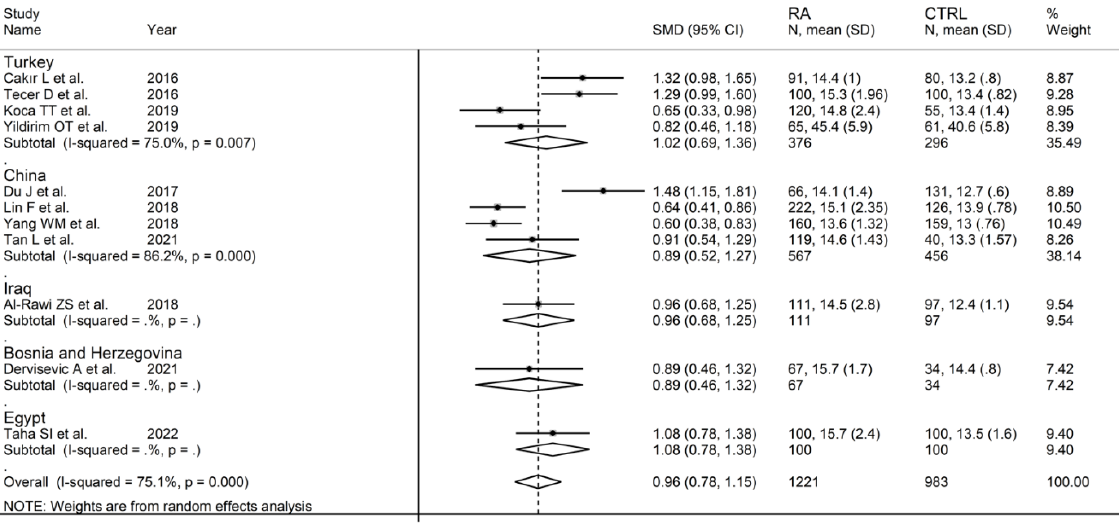
Figure 16. Forest plot of studies examining the red cell distribution width in patients with rheumatoid arthritis and healthy controls according to the country where the study was conducted.